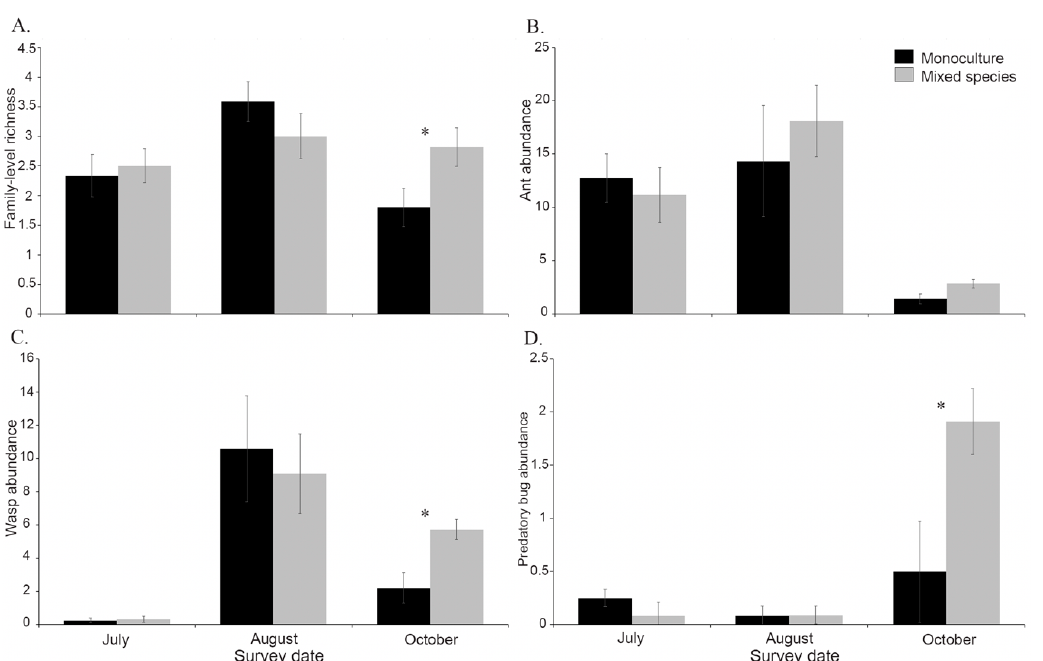
Figure 3. Natural enemy results based on yellow sticky card passive collections in July, August, and October 2019. Black bars represent mean ± SE values from swamp milkweed monoculture plots, while gray bars represent mixed-species plots. Panels show average ( A ) family-level natural enemy richness, ( B ) ant abundance, ( C ) wasp abundance, and ( D ) predatory bug abundance per date. Asterisks above bars indicate a statistical difference ( p < 0.05) between plant diversity treatments on that date.